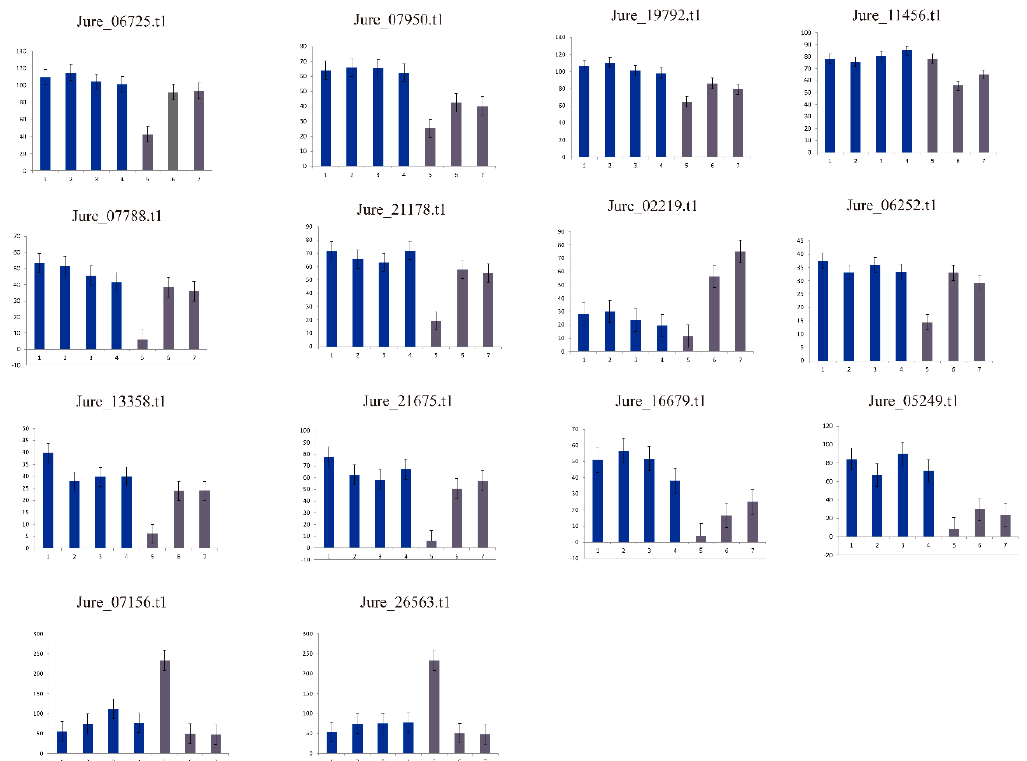
Figure 7. Expression of 14 F-box genes in various stages of female and male flowers. The X -axis represents female and male samples from different growth periods; 1, 2, 3, 4, 5, 6, and 7 represent 10 April, 15 April, 22 April, 1 May, 10 April, 11 April, and 2 May. The blue represents the expression level in female flowers, and the gray represents the expression level in male flowers. The Y -axis represents the relative expression level of F-box gene of common walnut. Error bars represent the standard deviations of three replicates. The expression level data are as shown in Table S5 (Supplementary Materials). We used two or three biological replicates from the same organization in the same period in Table S5 (Supplementary